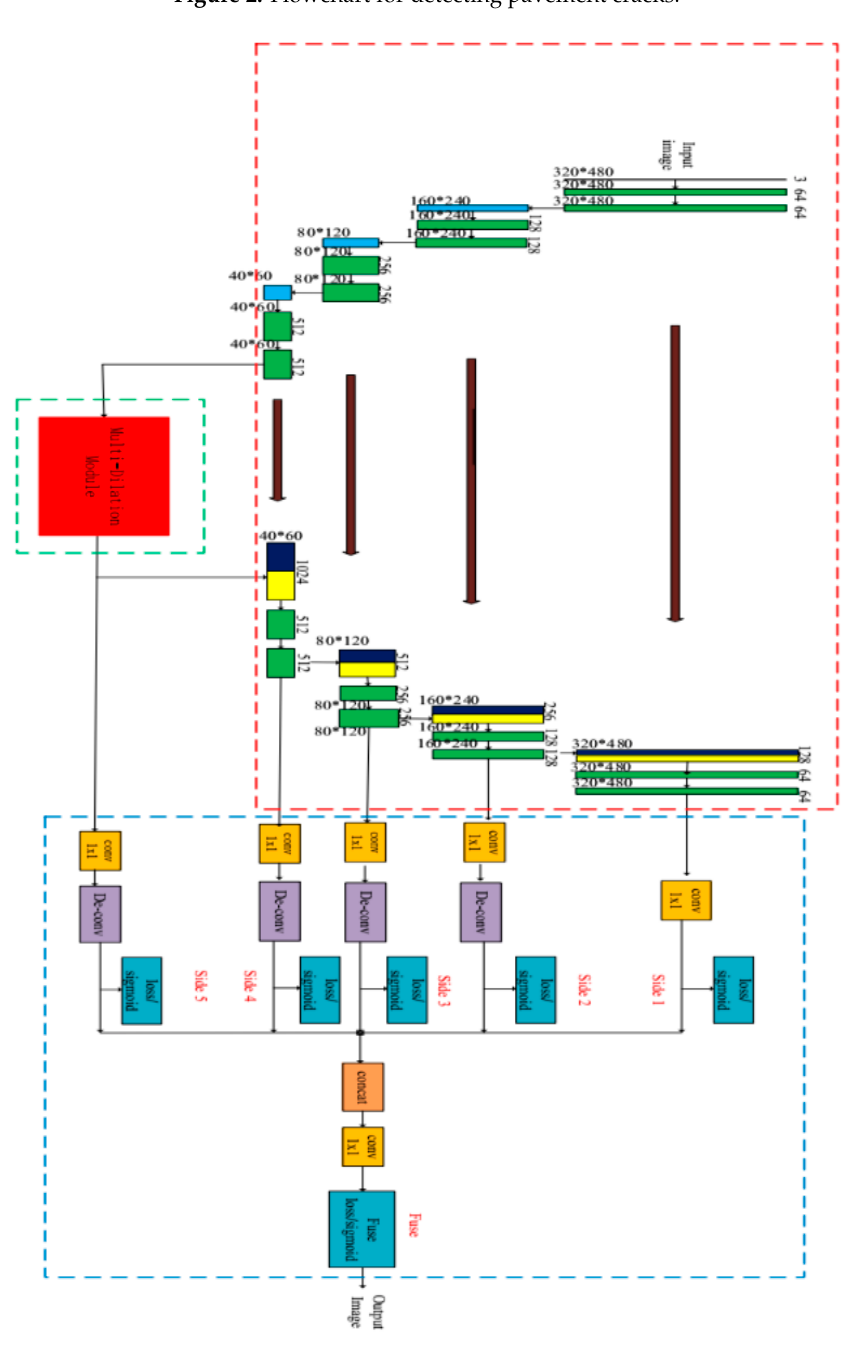
Figure 3. The proposed U-HDN architecture consists of three components: U-net architecture, multi-dilation module, and hierarchical feature learning module. The red dotted box presents the modified U-net; the green dotted box is a multi-dilation module; the blue dotted box shows the hierarchical feature learning module.